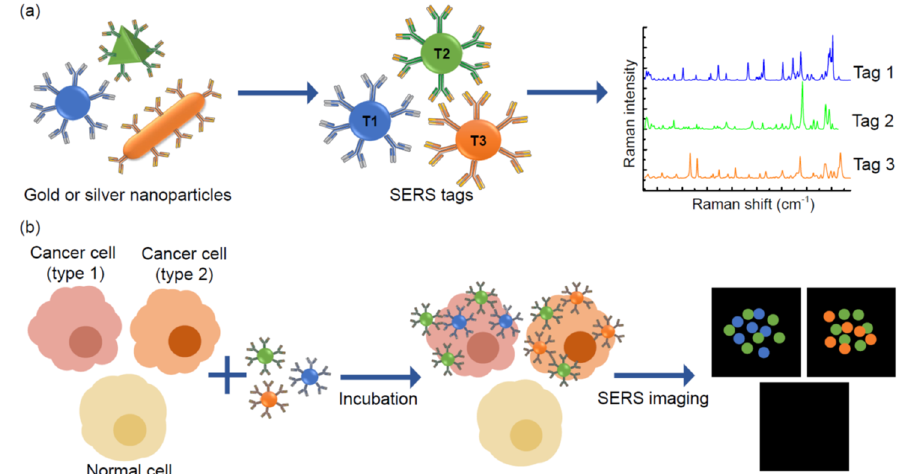
Figure 5. Principles of multiplexed detection using the surface-enhanced Raman scattering (SERS) technique. ( a ) Noble metal nanoparticles, that are different in size and shape, have unique Raman signals with narrow peaks, thus they could be used as SERS tags. ( b ) Schematic illustration of simultaneous detection of three tumour associated antigens expressed different types of cancer cells by SERS imaging.